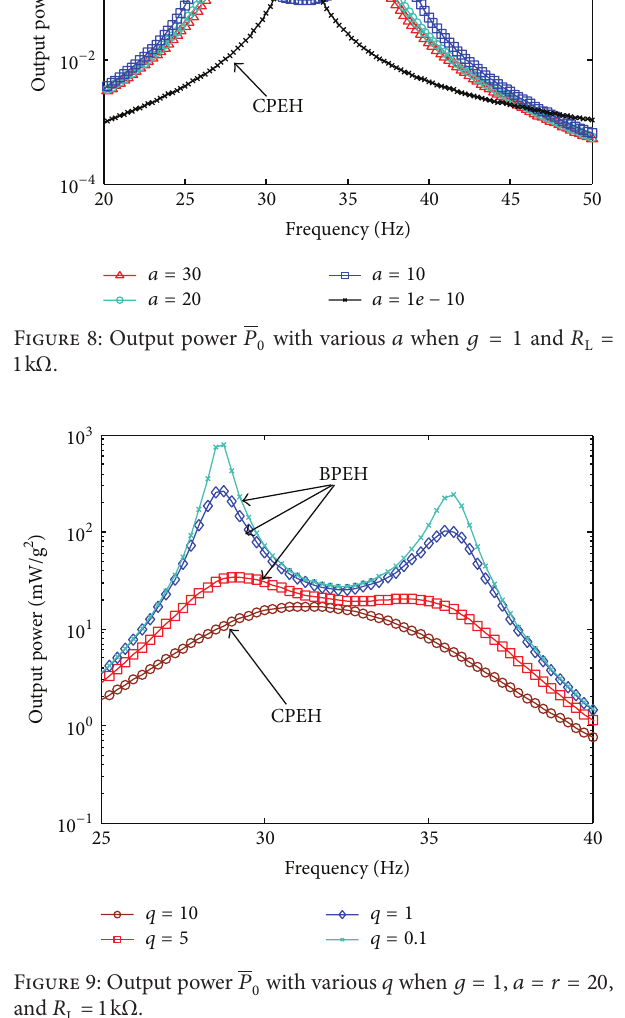
Figure 7: Output voltage 𝑉 0 with various 𝑎 when 𝑔 = 1 and 𝑅 L = 1k Ω .